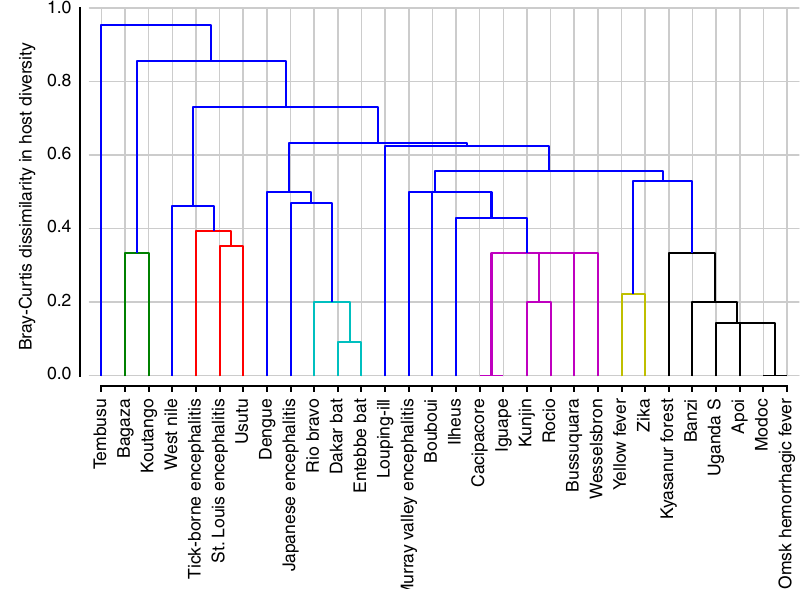
Fig. 1 Co-occurrence of avian and mammalian hosts among Flaviviruses. Cluster analysis of zoonotic fl aviviruses according to known host taxonomic orders and their Bray-Curtis dissimilarity index. Green, red, cyan, purple, yellow, and black lines show clusters of viruses with similar host taxonomic orders (Bray- Curtis dissimilarity index <